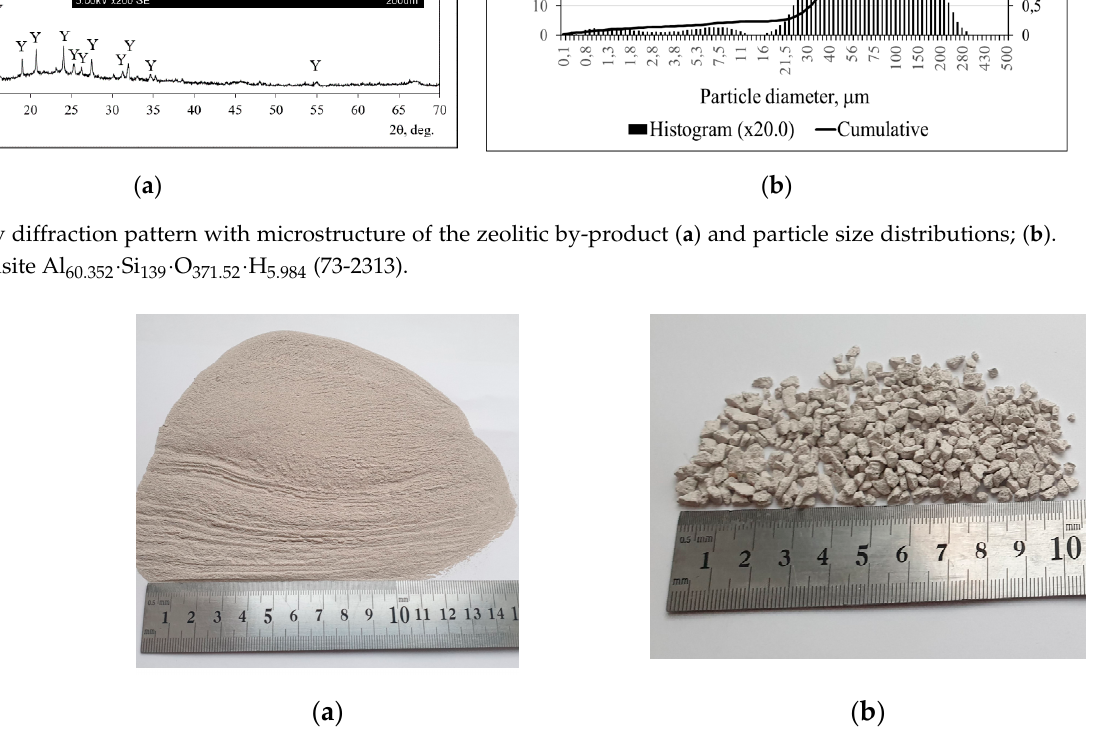
Figure 6. X-ray diffraction pattern with microstructure of the zeolitic by-product ( a ) and particle size distributions; ( b ). Note, Y is faujasite Al 60.352 ∙ Si 139 ∙ O 371.52 ∙ H 5.984 (73-2313).